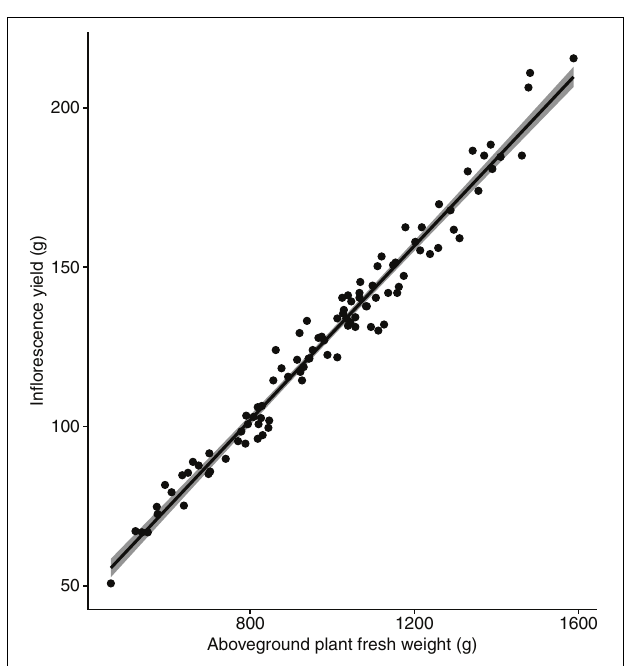
FIGURE 4 | Correlation between inflorescence yield (g/plant) and aboveground plant fresh weight (g/plant) of Cannabis sativa ( r = 0.98, P < 0.001). Shaded area represents 95% confidence